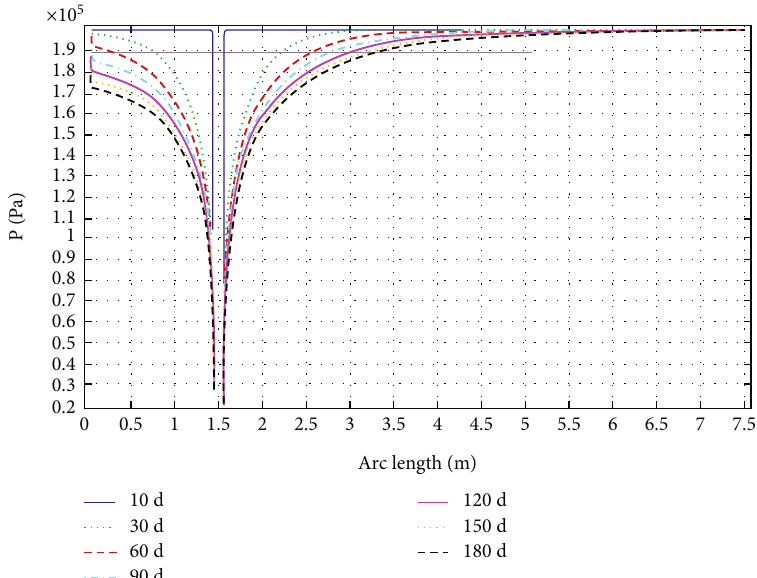
Figure 8: Gas pressure relief curve of single-hole fracturing